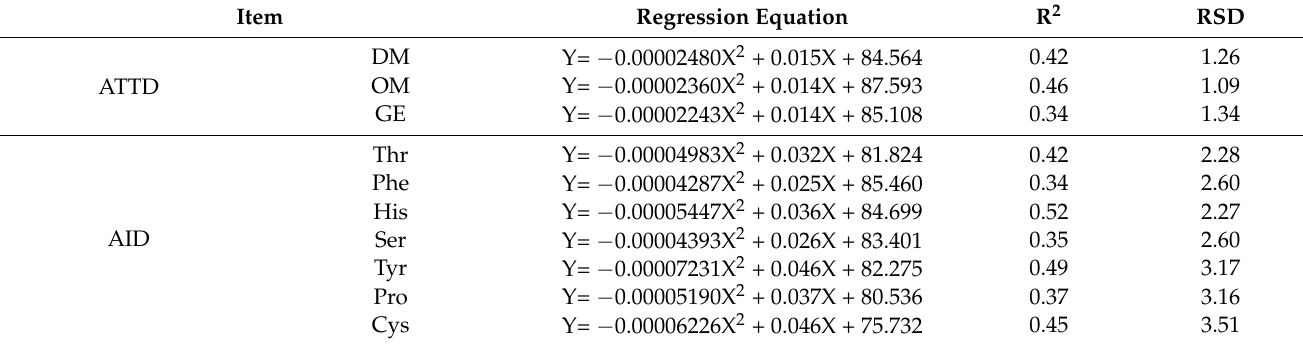
Table 12. Appropriate regression equation between protease concentration and each significant